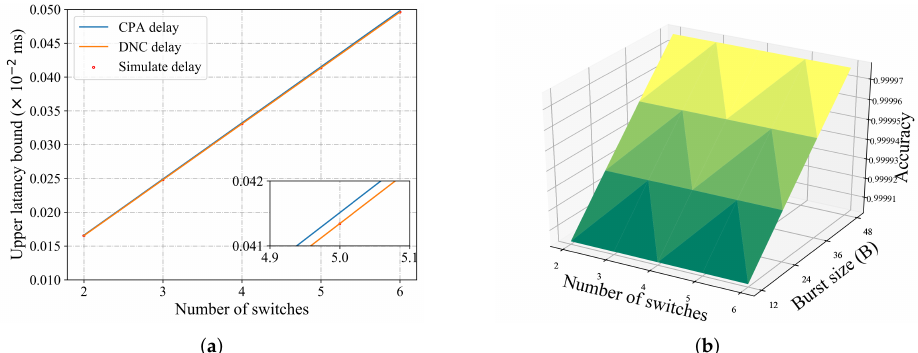
Figure 4. Single flow with multi-switch: ( a ) End-to-end delay versus number of switches (when burst size is 12 B), and ( b ) accuracy of theoretical and simulated values versus the number of switches when the burst size is 12–48 B.